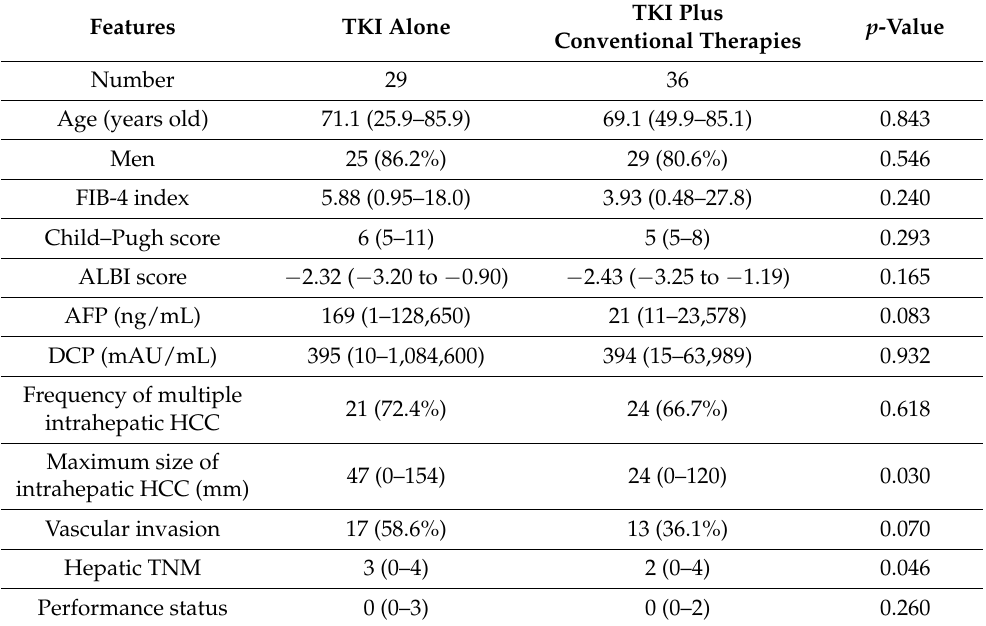
Table 3. Background data of patients who received TKI alone and TKI plus convention